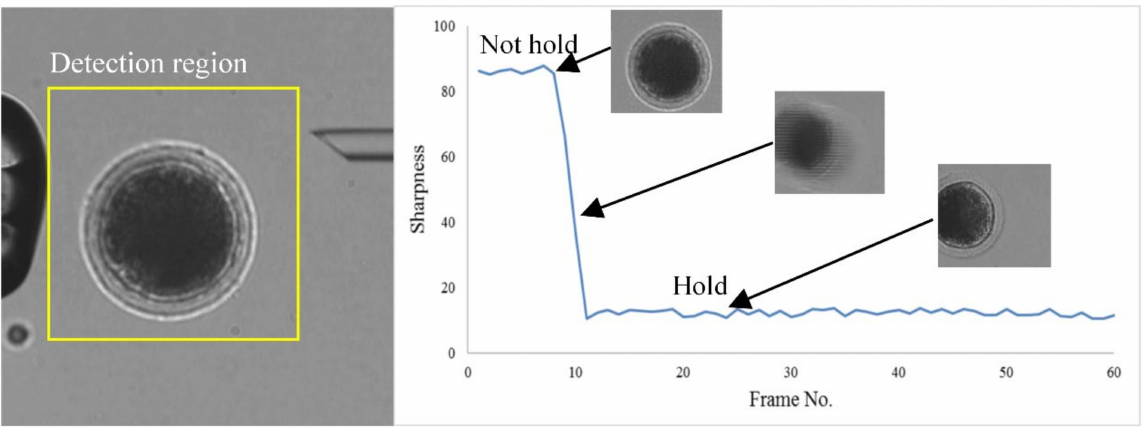
Figure 5. Sharpness of the detection region for cell immobilization